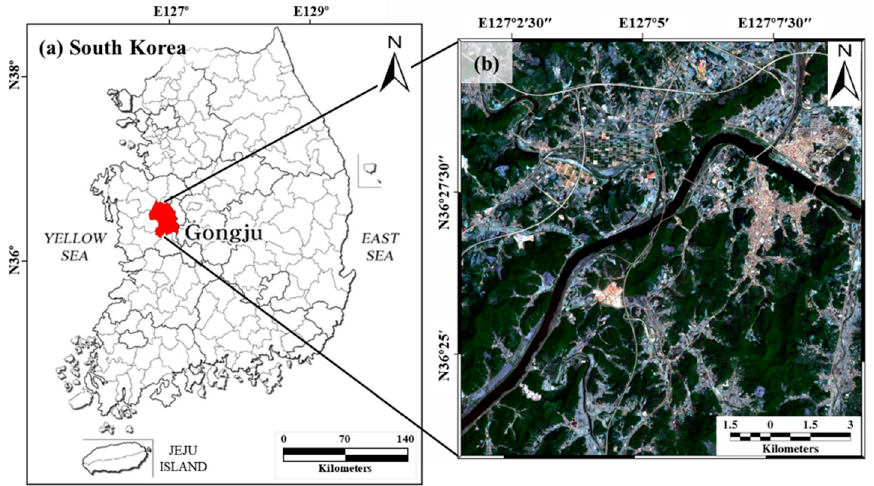
Figure 1. Study area: ( a ) Gongju, South Korea and ( b ) Sentinel-2 ortho-rectified image in the study area.